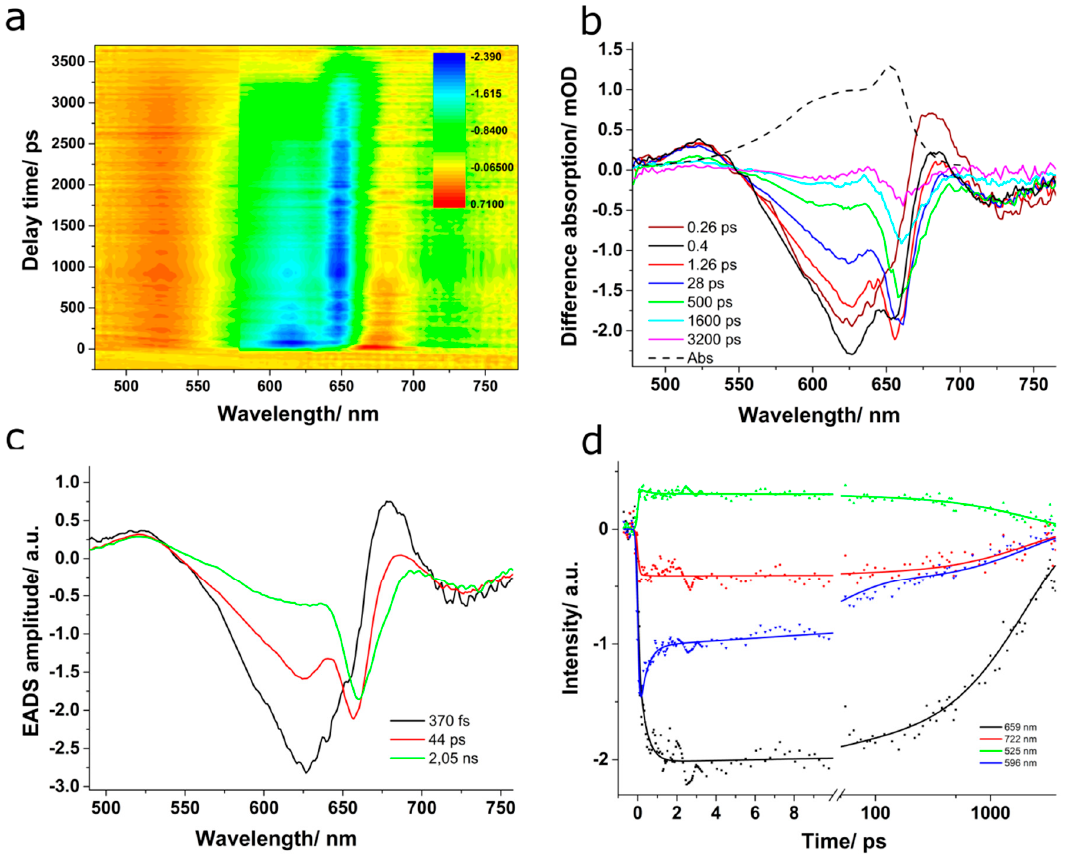
Figure 6. ( a ) 3D transient absorption data carpet obtained from allophycocyanin (APC) pumped at 580 nm, ( b ) transient absorption spectra of APC showing bleach recovery of the ground state as a function of time delay between pump and probe pulses; the UV-Vis absorption spectrum is also shown (dash line), ( c ) the evolution-associated difference spectra resulted following global analysis, and ( d ) examples of kinetic traces together with the obtained fits.